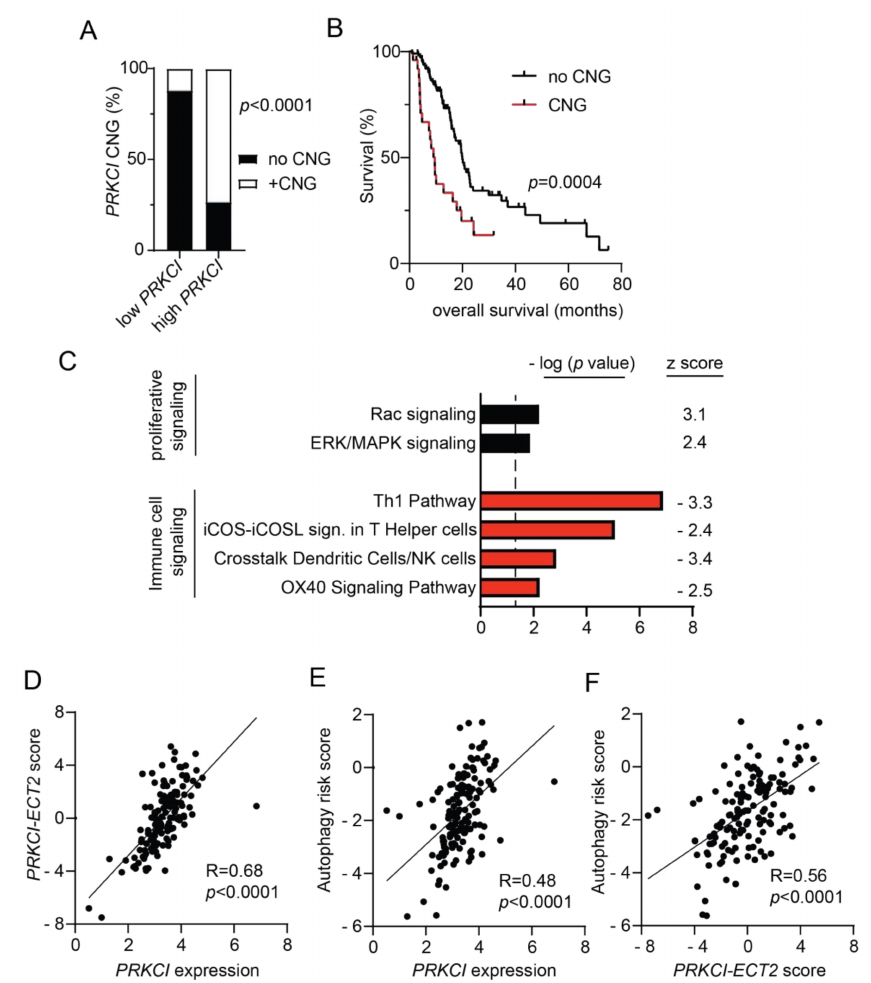
Figure 7. Characterization of PRKCI in human PDAC. ( A ) Distribution of tumors without PRKCI CNG (GISTIC score − 1, 0) and with PRKCI CNG (GISTIC score +1, +2) in low PRKCI and high PRKCI groups defined in Figure S9A. Fisher exact analysis was used to assess the significance of differences between groups. ( B ) Kaplan-Meier analysis of overall survival of PDAC patients surviving >30 days after surgery with PRKCI CNG ( n = 25) and no PRKCI CNG ( n = 113) is plotted. ( C ) Gene expression analysis of the TCGA PDAC dataset identified genes with a significant difference in expression between the 25% PDAC tumors with the highest PRKCI expression ( n = 36) and the 25% PDAC tumors with the lowest PRKCI expression ( n = 36). Ingenuity pathway analysis of differentially expressed genes revealed signaling pathways that are significantly altered between the groups. Bars represent the ( − log) p -values of the significance of the pathway and the number to the right indicates the z score. Black bars indicated pathways with a positive z score, red bars indicate pathways with negative z scores. ( D ) Scatter plot showing the relationship between log PRKCI mRNA expression and the PRKCI-ECT2 pathway score in all TCGA PDAC. ( E ) Scatter plot showing the relationship between log PRKCI mRNA expression and autophagy risk score in all TCGA PDAC tumors. ( F ) Scatter plot showing the relationship between PRKCI-ECT2 pathway score and autophagy risk score in all TCGA PDAC. Spearman’s correlation coefficient ( R ) and significance ( p -value) are indicated in panels ( D – F